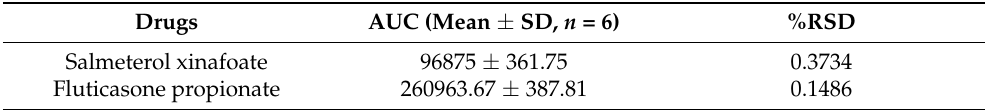
Table 4. AUC (mean ± SD, n = 6) and %RSD for salmeterol xinafoate and fluticasone propionate determined from the HPLC